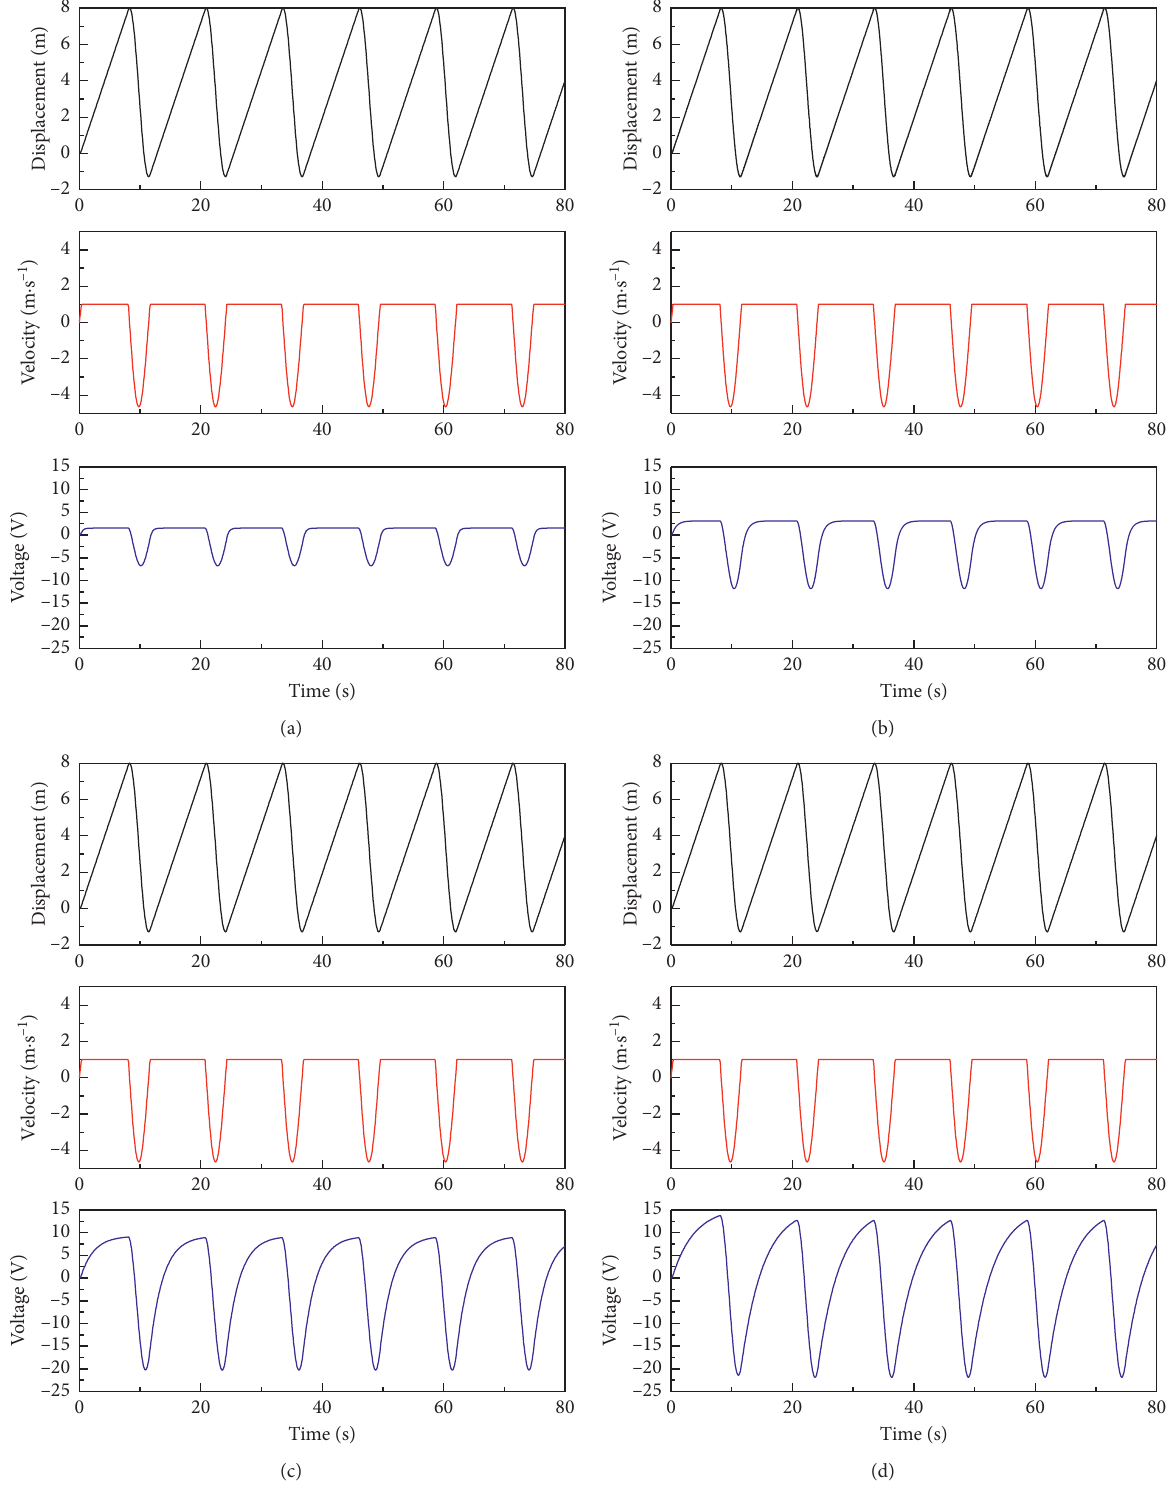
Figure 9: The displacement, velocity, and output voltage of the friction system when the load resistance is R � 50000 Ω (a), R � 100000 Ω (b), R � 300000 Ω (c), and R � 500000 Ω (d) in the friction law